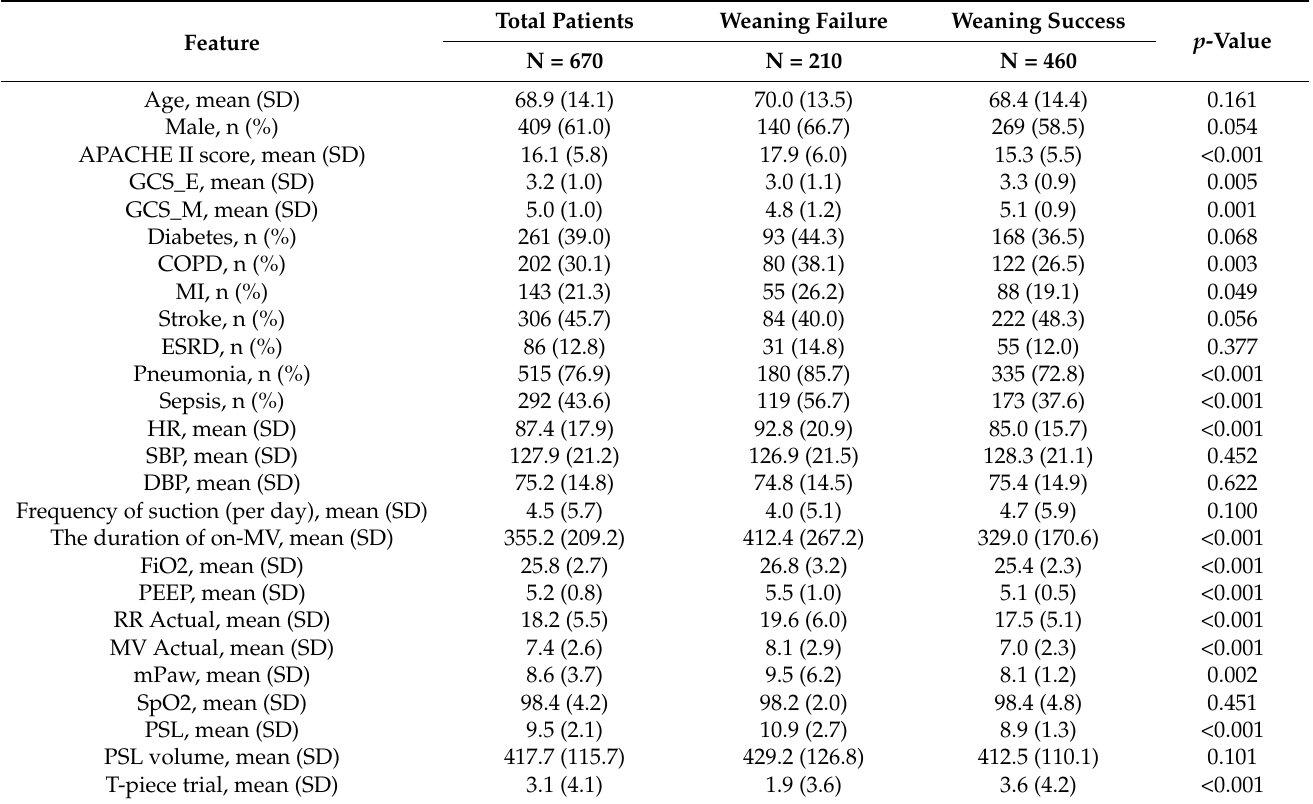
Table 1. Demographics and baseline statistical